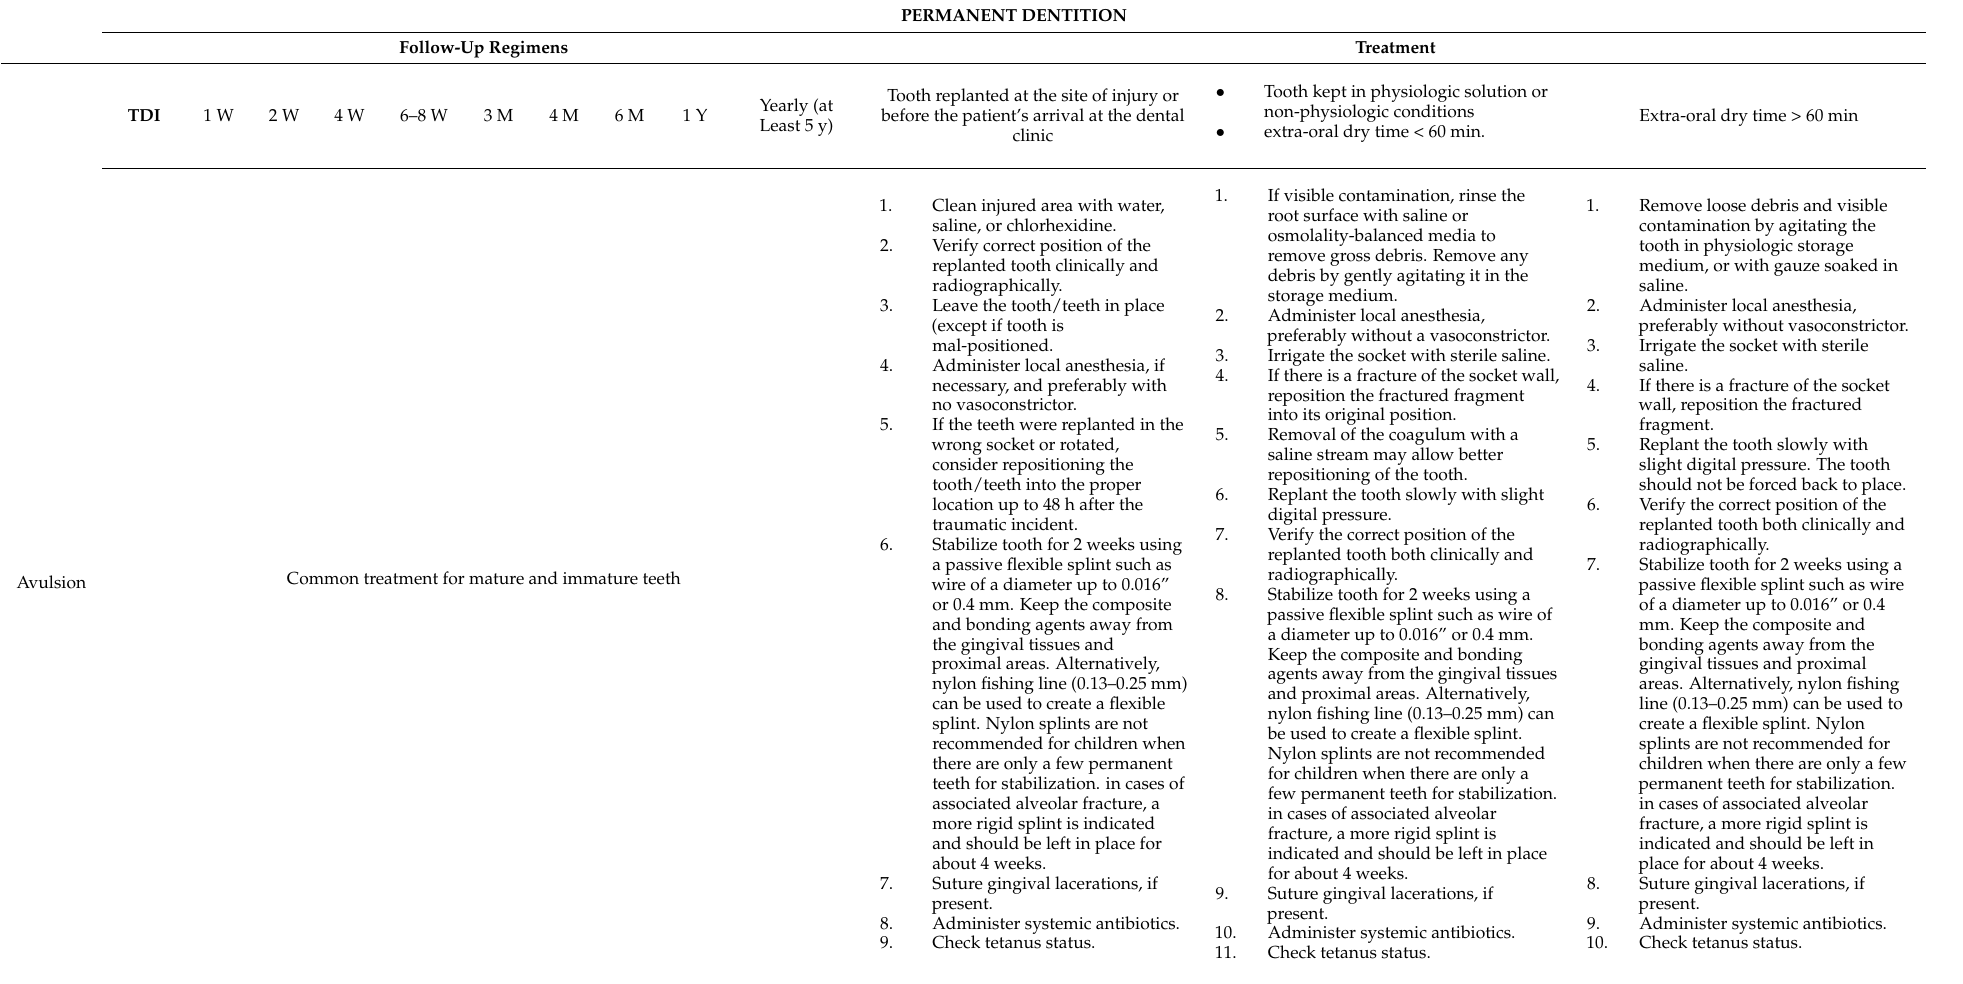
Table 3. Treatment of tooth avulsion. Follow up regimens in weeks, months and years are listed, as well as the possible treatment options according to the different scenarios of tooth replanted at the site of injury, dry time of less or more than 60 min. S = SPLINT REMOVAL; R = RADIOGRAPH ADVISED EVEN IF NO CLINICAL SIGNS OR SYMPTOMS; RCT = root canal treatment; Adapted from Levin L et al. [15] and Bourguignon, C et al.